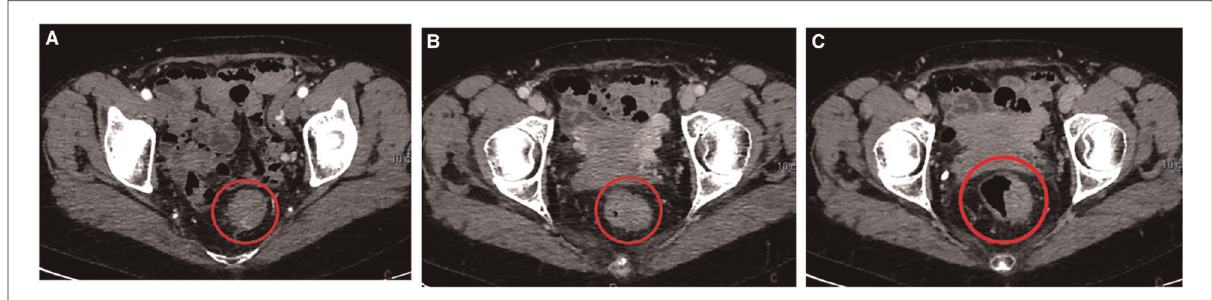
FIGURE 1 ( A ) contrast enhanced computer tomography, arterial phase. Red circle marks the rectum. ( B ) Contrast enhanced computer tomography, portal phase. Red circle marks the rectum, ( C ) Contrast enhanced computer tomography, nephrogenic phase. Red circle marks the